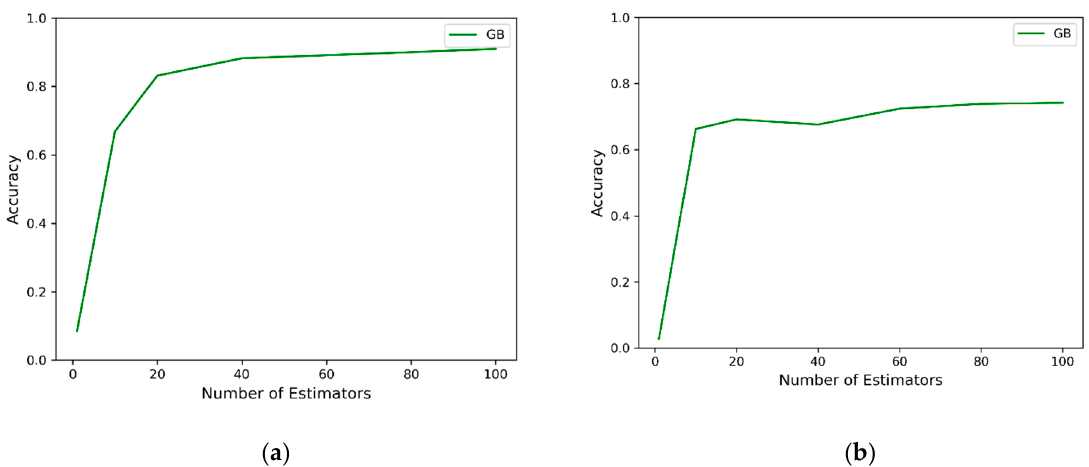
Figure 10. The test dataset accuracy corresponding to the number of boosting stages for Gradient Boosting algorithm for ( a ) plastic viscosity and ( b ) apparent viscosity.